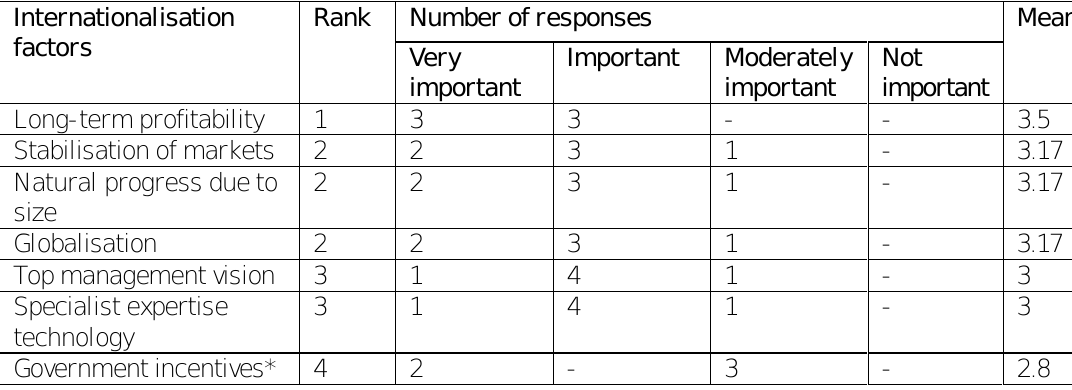
Table 8: Motivating factors for internationalisation Number of responses